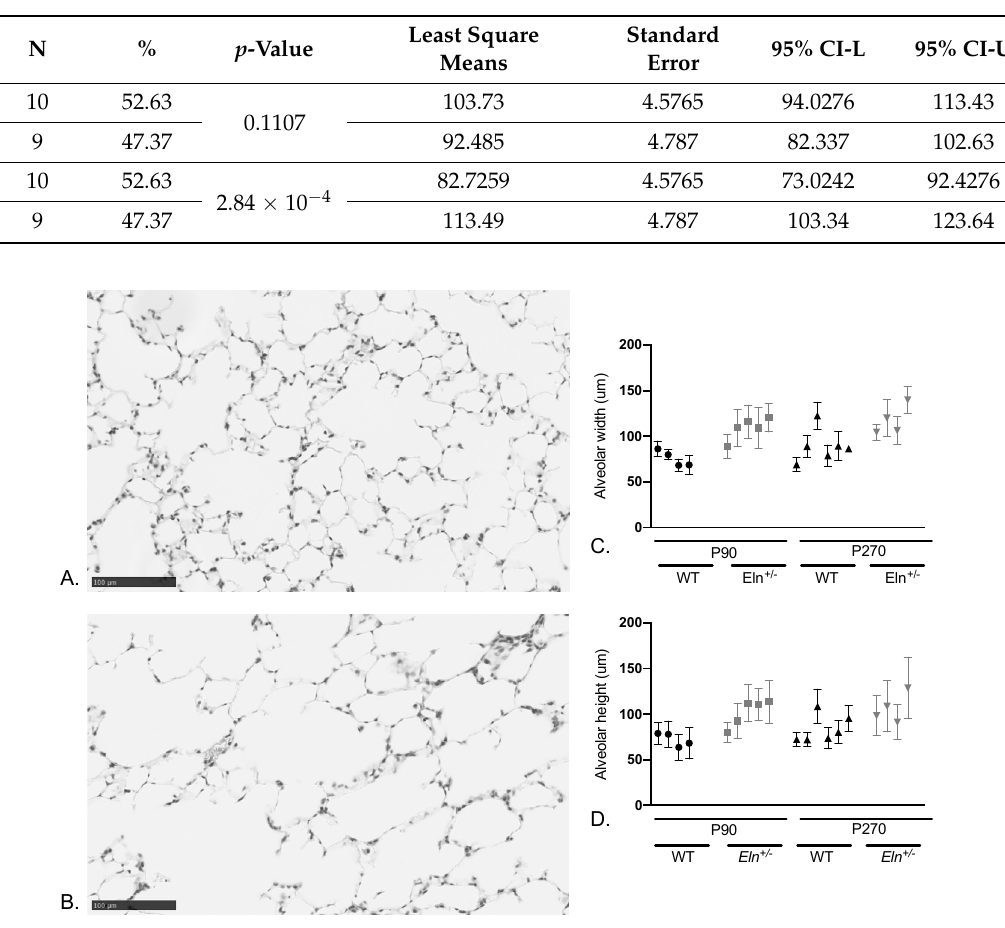
Figure 3. Histological analysis reveals larger airspaces in Eln +/ − mouse lungs as compared to WT. Representative hematoxylin and eosin-stained image of ( A ) WT and ( B ) Eln +/ − right lower lung. Graphical representation of Eln +/ − and WT airspace width ( C ) and height ( D ) measured by mean linear intercept (mean +/ − SD) and plotted for each animal. Eln +/ − animals at age P90 and P270 are indicated in gray and WT in black. Table 3. Linear mixed effects model results for horizontal intercepts. Eln +/ − mouse lungs have larger airspaces, however, there is no statistically significant difference in airspace size with age. See Table S2 in the online data supplement for vertical intercept results. Abbreviations: 95% CI-L: 95% confi- dence interval lower limit, 95%% CI-U: confidence interval upper limit.